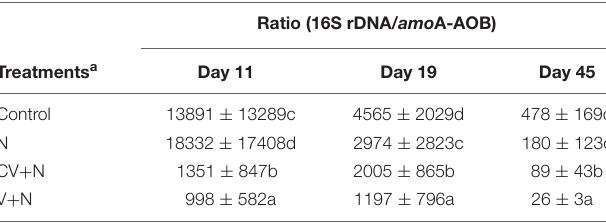
TABLE 2 | Ratios between the gene copy numbers (per gram of dry soil) of ammonia-oxidizing bacteria ( amoA -AOB) and total bacteria 16S rDNA ( n =